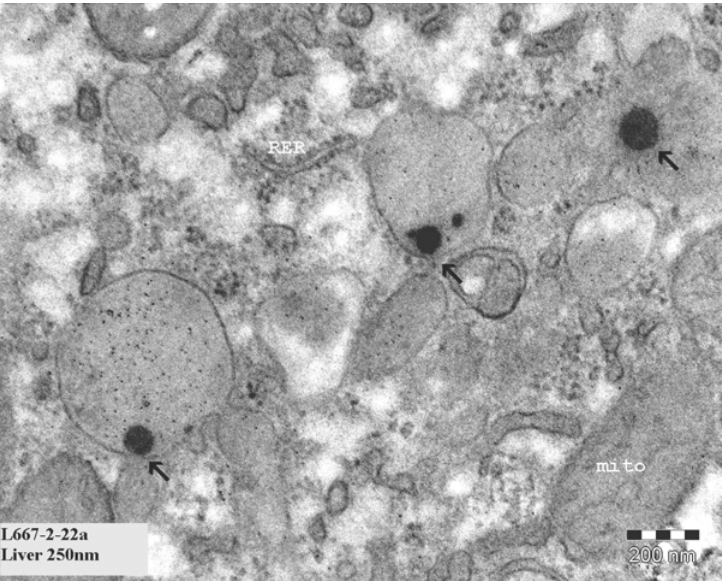
Figure 5. Presence of 100–200 nm structures in liver cells. The marker indicates 200